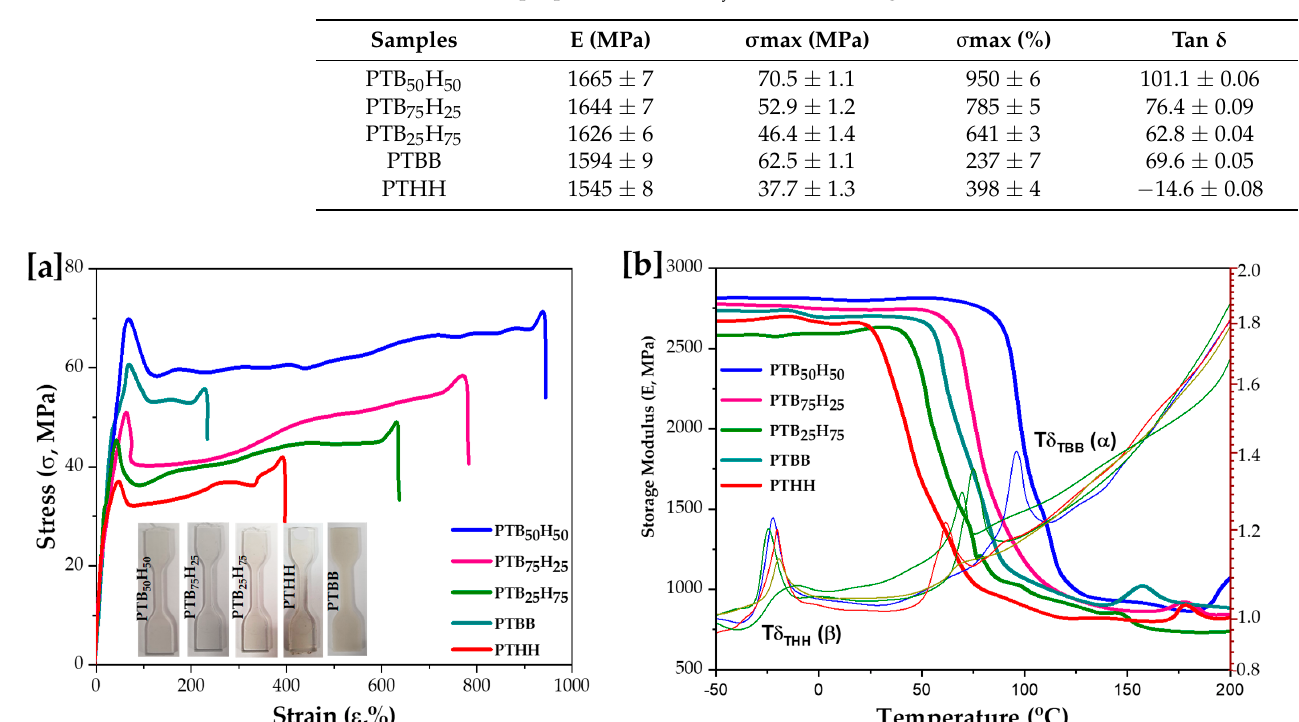
Table 3. Mechanical properties of PTB x H y and its homologs.